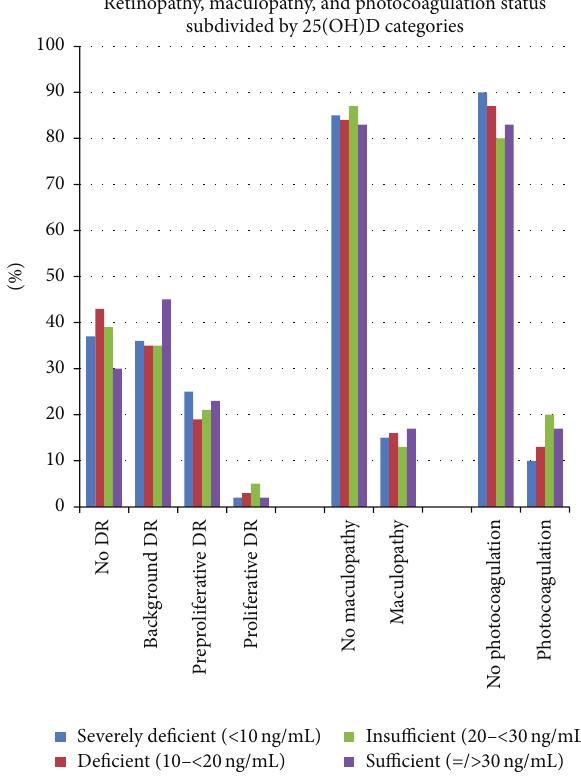
Figure 1: Frequencies of retinopathy, maculopathy, and photocoag- ulation scarring categorised by 25(OH)D